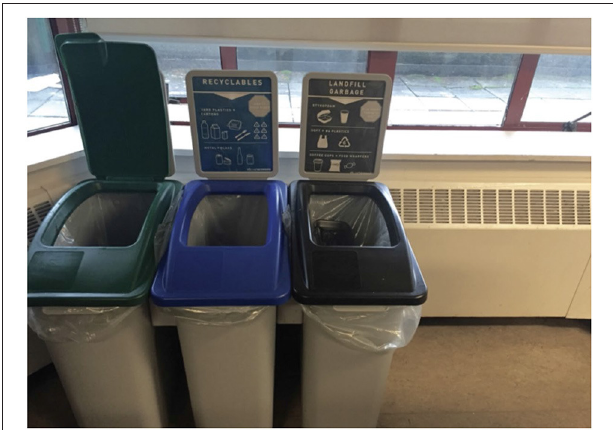
FIGURE 5 | From left to right: The first image shows how the Demo scale is resting on top of a standard and covered with a plate (i.e., this whole unit is placed inside the green compartment). The second image shows a top view of the scale and a Raspberry Pi inside the green compartment without the plate cover. The third image shows a top view with the plate cover and the scale underneath it. The plate cover allows for rebooting the scale and visibility of system status.